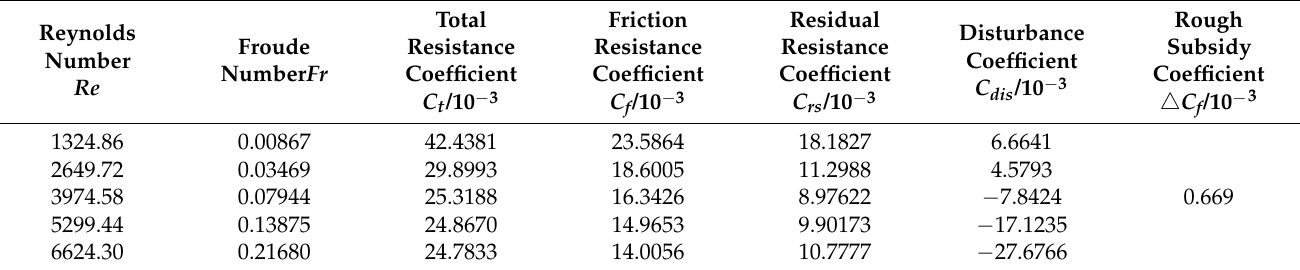
Table 8. Dimensionless results of diver–DPV